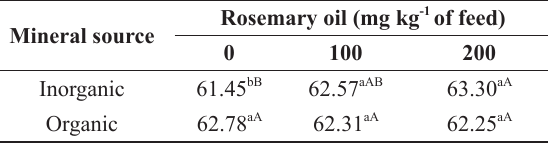
Percentage composition of albumen of eggs from laying hens fed different mineral sources and rosemary oil levels.